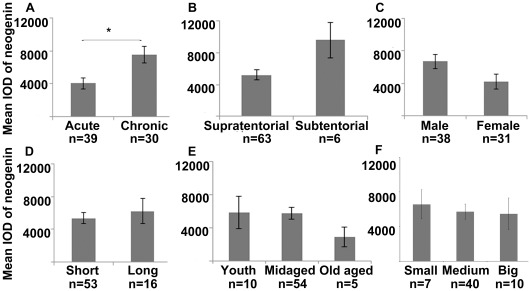
The classified statistics of neogenin expression in 69 primary gliomas.(A–D) Histograms of mean neogenin levels in different statistic groups: (A) tumor latency, (B) tumor location, (C) gender, (D) duration of being in hospital, (E) age, (F) tumor size. N, the number of cases in different statistic groups, statistical methods were performed with independent t-test and One-Way ANOVA, *p<0.05, error bars indicate standard error means.